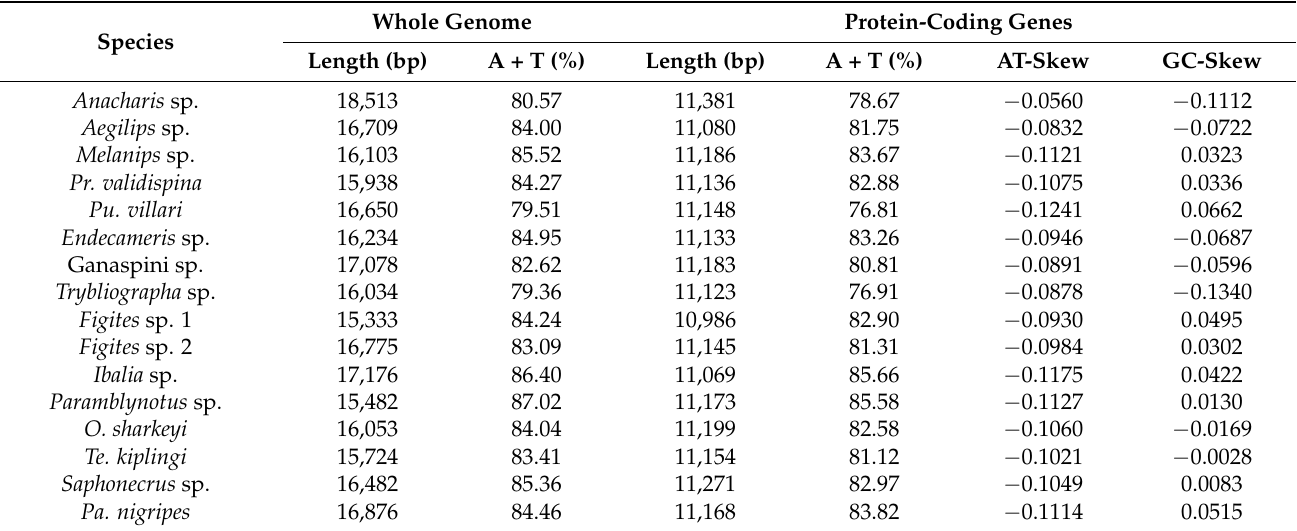
Figites sp. 1 Figites sp.